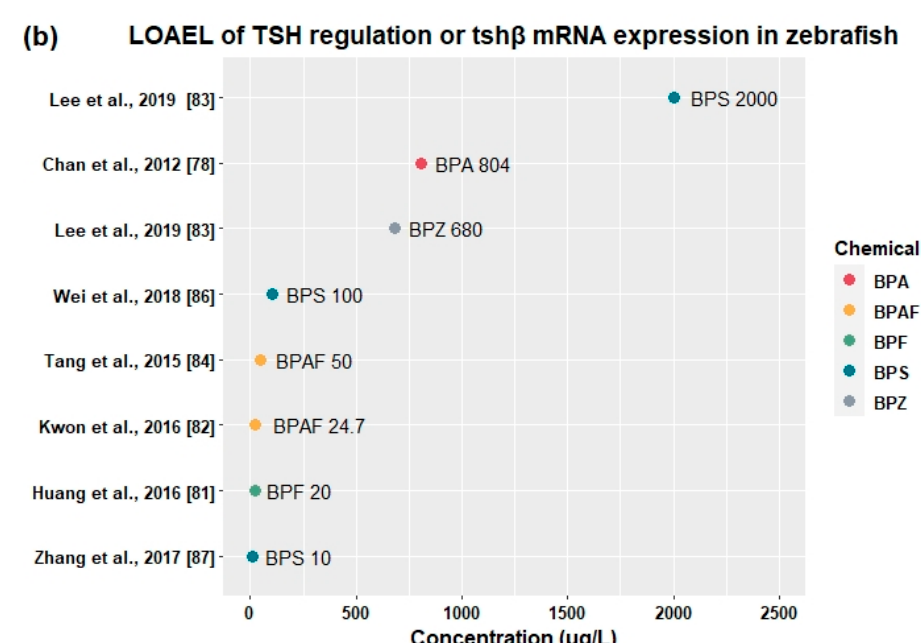
Figure 5. Lowest observed adverse effect level (LOAEL) of thyroxine (T4) hormone ( a ), thyroid stimulating hormone (TSH) or tsh β mRNA expression ( b ) in zebrafish exposed to BPA, BPAF, BPF, BPS, and BPZ.